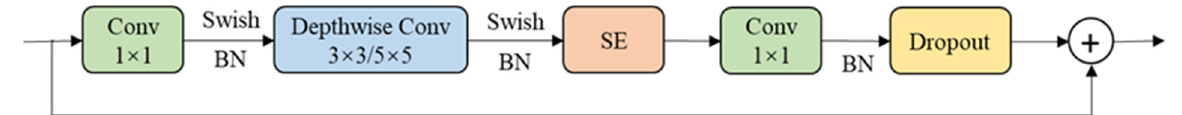
Figure 2. The structure of Mobile Inverted Bottleneck Convolution (MBConv).